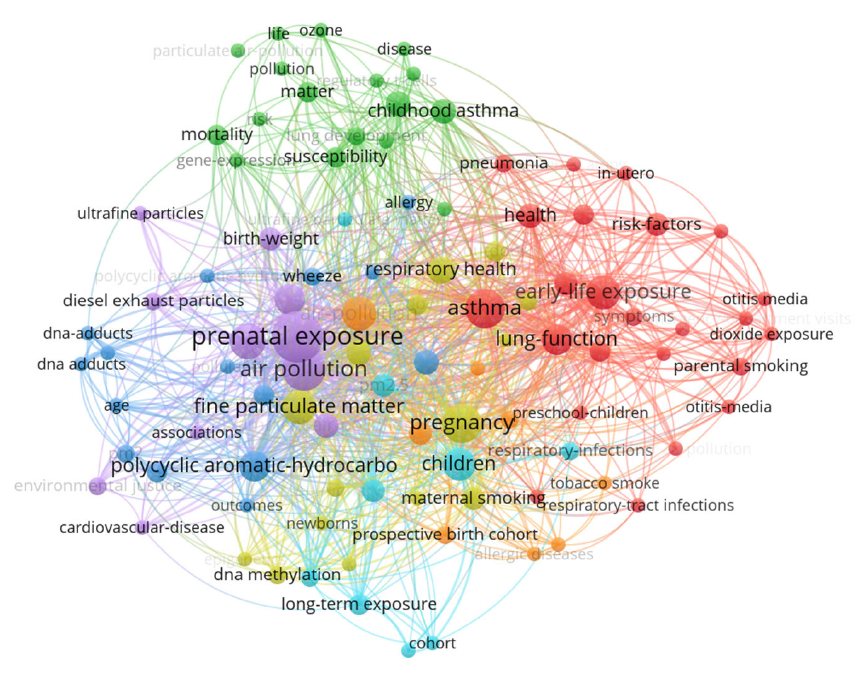
Figure 10. Keyword co ‐ occurrence map.